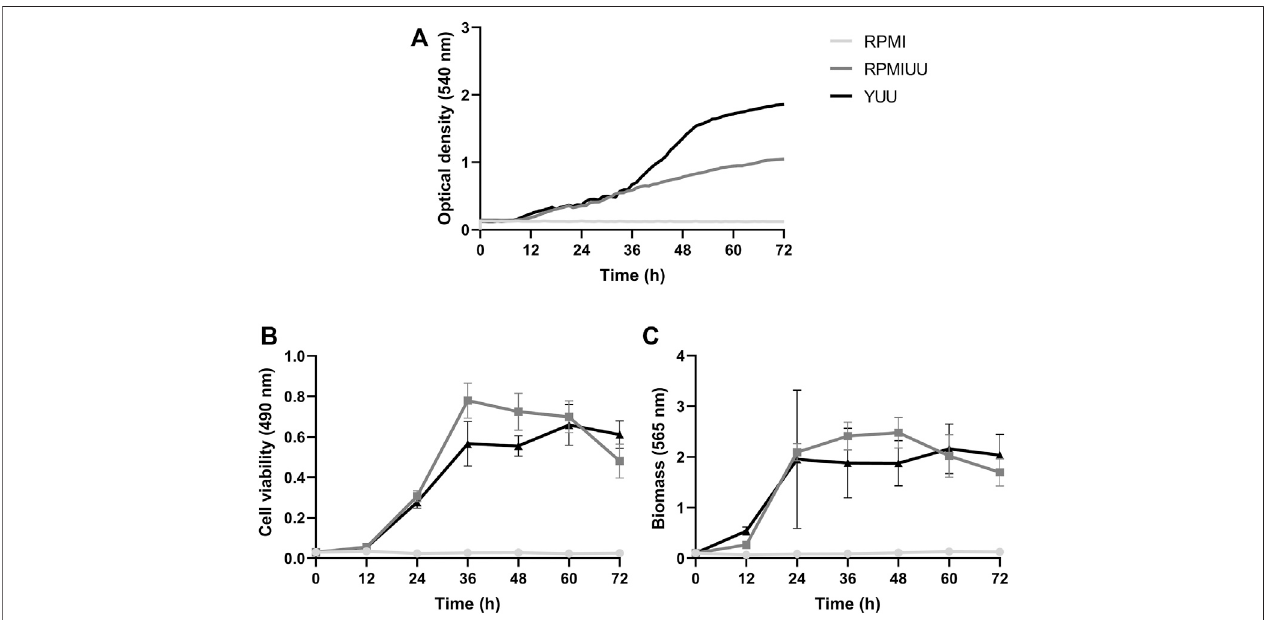
FIGURE2| A.nidulans bio fi lmformationinRPMI,RPMIUU,andYUUmedia.10 4 conidia/mLwereincubatedinRPMI,RPMIUU,andYUUmediainpolystyrene96- well plates for 72 h at 37 ° C. (A) Optical density analysis; (B) Cell viability analysis; and (C) Biomass quanti fi cation of A. nidulans bio fi lm formation over 72 h. Error bars representstandarddeviationsfromthemeanoftwoindependentexperimentsperformedintriplicate.Signi fi cantdifferences( p < 0.05)arerepresentedbyasteriskswhen the RPMI UU growth kinetics were compared to the YUU medium. ** p < 0.01; **** p <